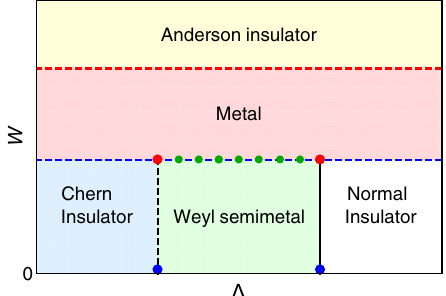
FIG. 1. A schematic phase diagram of a dirty Weyl semimetal. Here, Δ is a tuning parameter that drives quantum phase transition from Weyl semimetal to (Chern or normal) insulator in clean system [see Sec. II], and W denotes the strength of disorder (the nature of which is not specified here). Semimetal- insulator quantum-critical points are denoted by the blue dots. The red dots represent multicritical points, where an insulator, a metal, and the Weyl semimetal meet [see Sec. III]. The string of green dots represents a line of quantum-critical points through one of which (depending on the bare value of Δ ) the Weyl semimetal undergoes a quantum phase transition into a metallic phase (see Secs. IV, V, VI, and VII). At stronger disorder the metallic phase undergoes a second quantum phase transition into the Anderson insulator phase (see Sec. IX). The shape of the phase boundaries is, however, nonuniversal. See, for example, Fig. 2 for numerically obtained phase diagram from a lattice